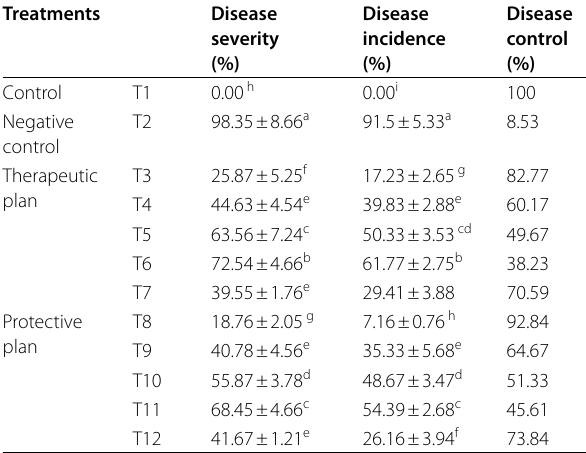
Table 3 Disease severity, incidence, and control of different treatment plans against wilt